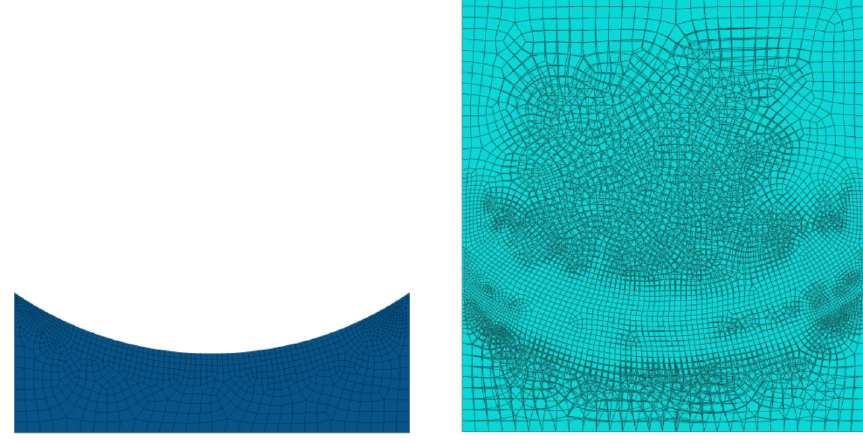
Figure 6. FE model of the paperboard portion (left) and overall assembly (right).